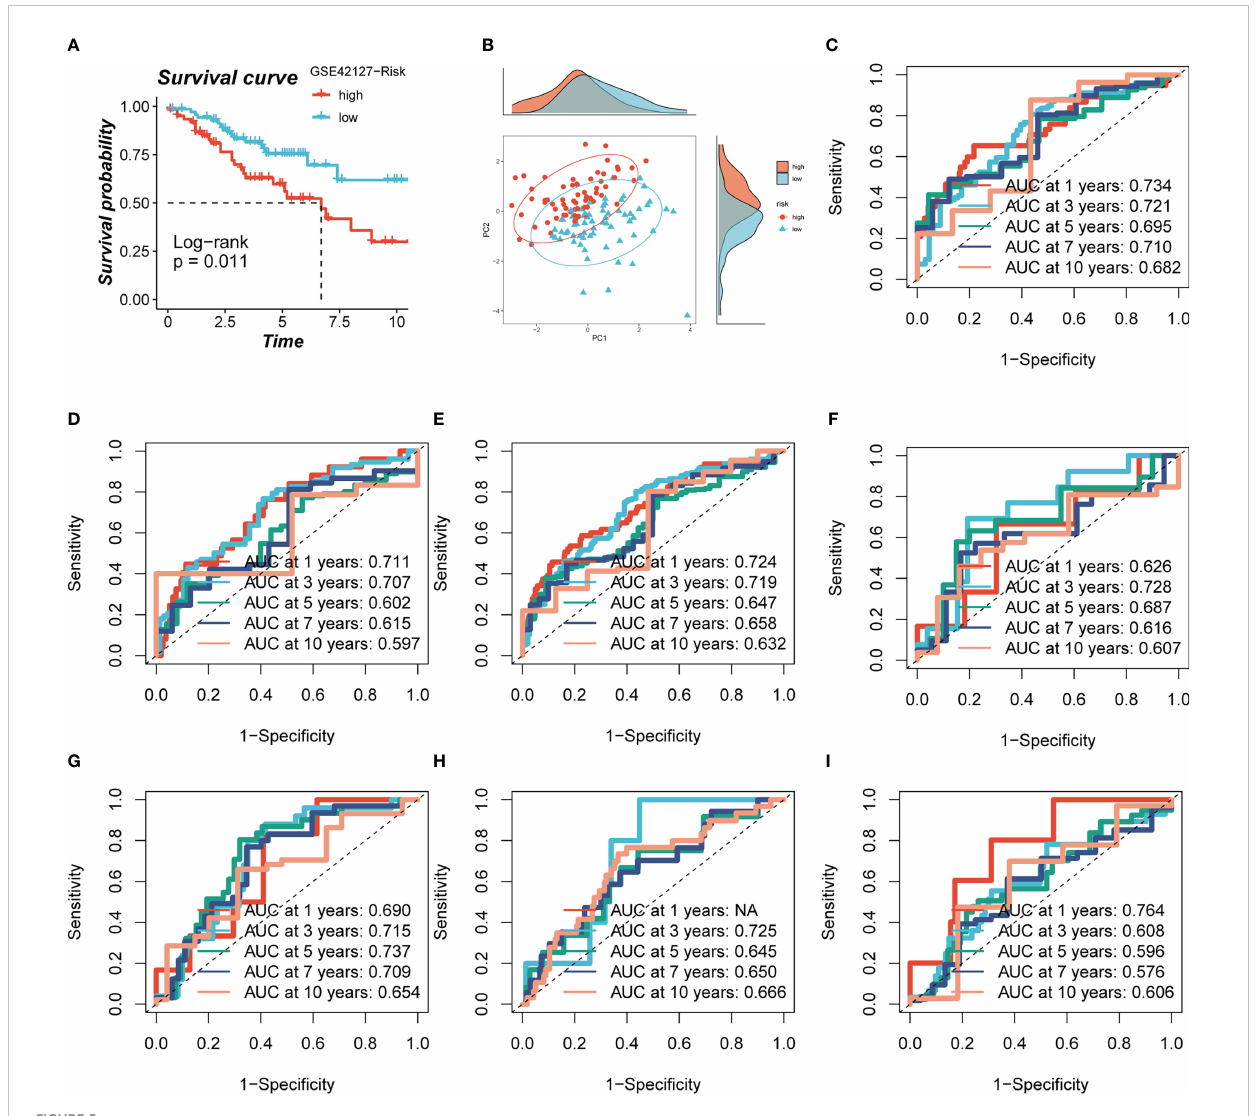
FIGURE 5 Evaluation of model. (A, B) Survival analysis revealed the survival signi fi cance of high and low risk scores in the GSE42127 cohort, and the sample distribution of high and low risk groups was shown in the PCA plot. (C-I) The ROC curve showed the survival accuracy of the model in TCGA (train, test, and all set) and GEO (GSE29016, GSE30219, GSE31210 and GSE42127)